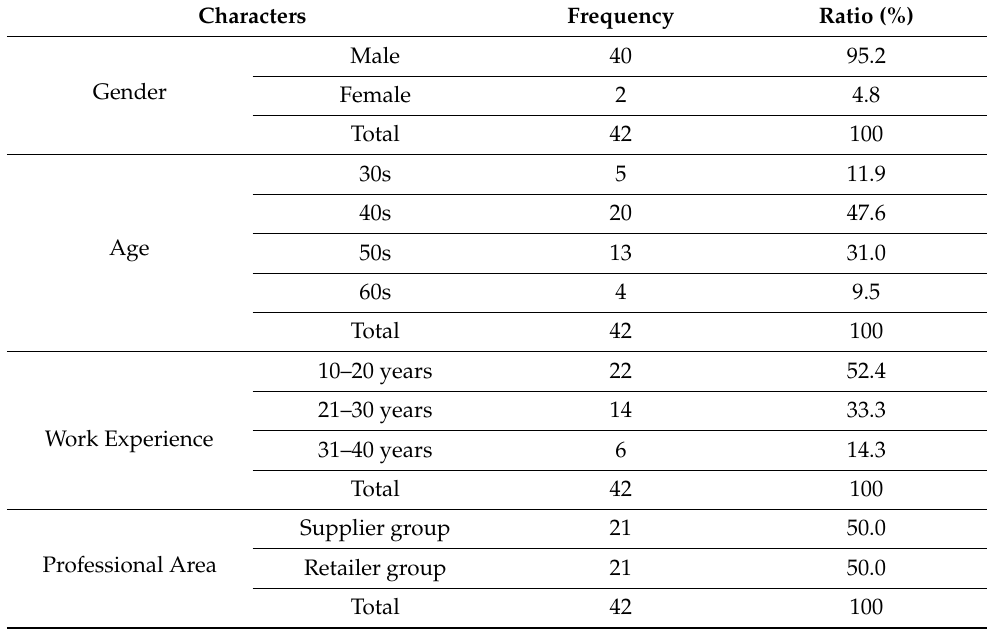
Table 3. Demography